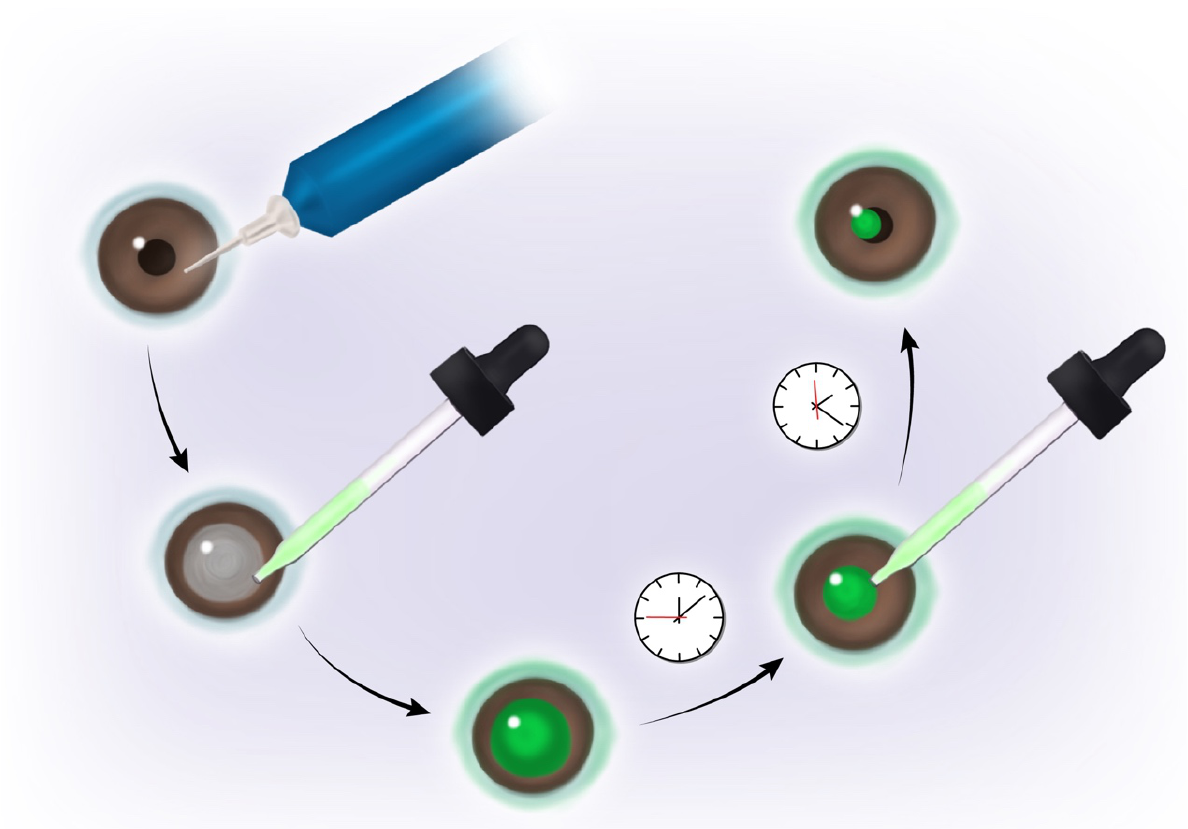
Figure 1. Monitoring Corneal Wound Healing. Corneal epithelial wounds are created with an Alger brush, which is used to scrape off the corneal epithelium. Exposure of the underlying stroma allows visualization of the wound with the dye fluorescein, which binds to the stroma but not the intact epithelium. The rate of wound healing can be monitored over time by measuring the percentage of the wound area remaining as visualized with fluorescein. Agents of interest can be topically applied to the corneal surface (once or repeatedly) to determine their impact on corneal wound healing.